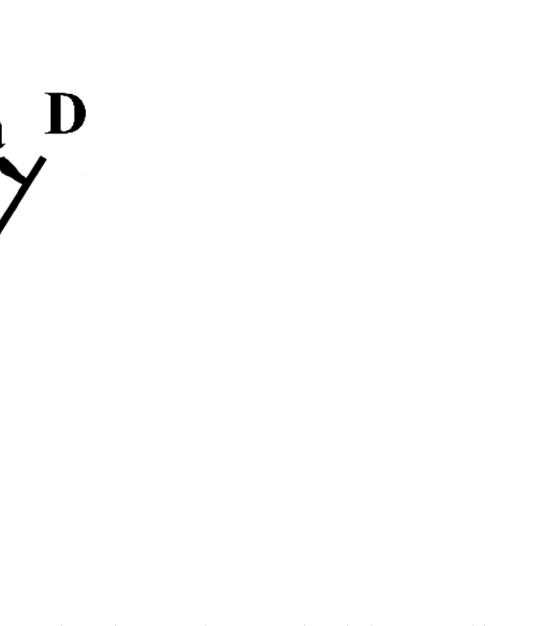
Figure 2. The structure diagram of the complexes between heteronuclear halogens and benzene. Table 1. The values of the interaction energy and the angle of a. Complexes a ( ◦ ) (E) Interaction Energy (kJ/mol)